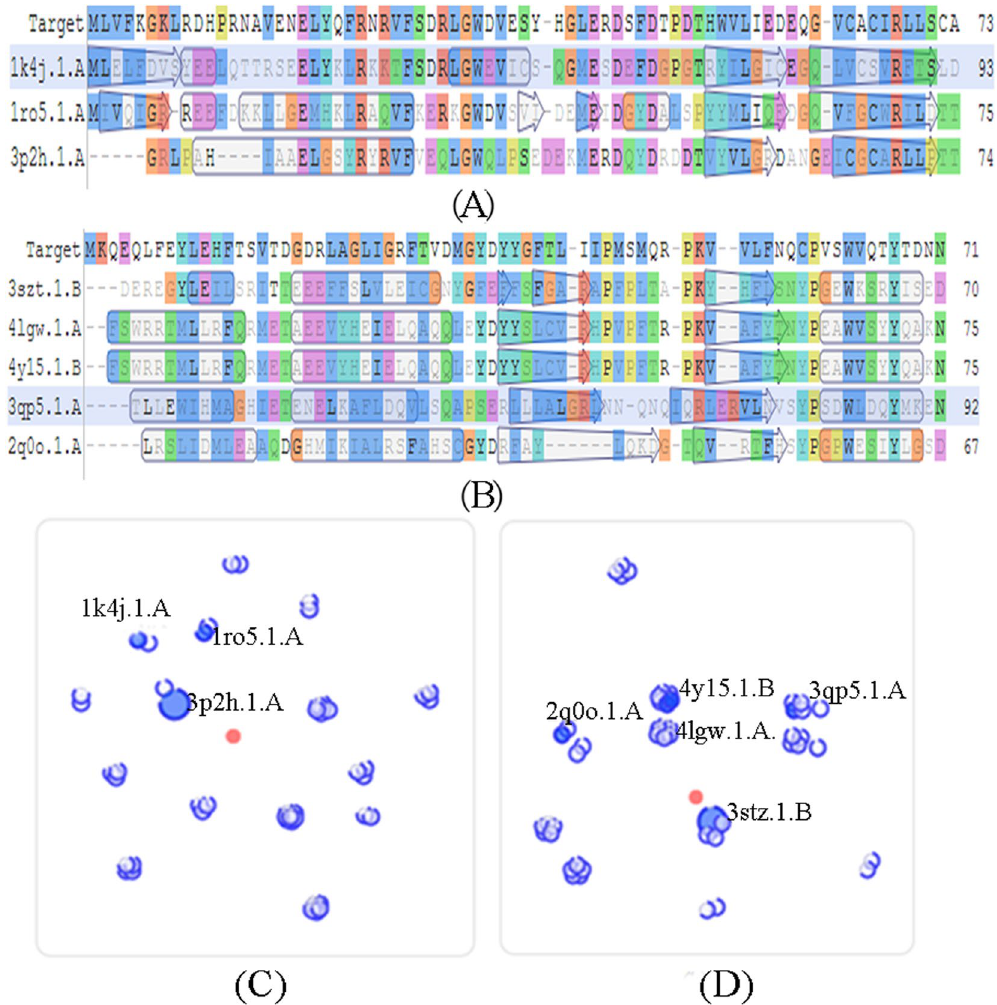
Figure 6. Part of sequence alignment results of LuxI (1) and LuxR type (2) proteins of A. sobria and their plots of scores (3: LuxI; 4: